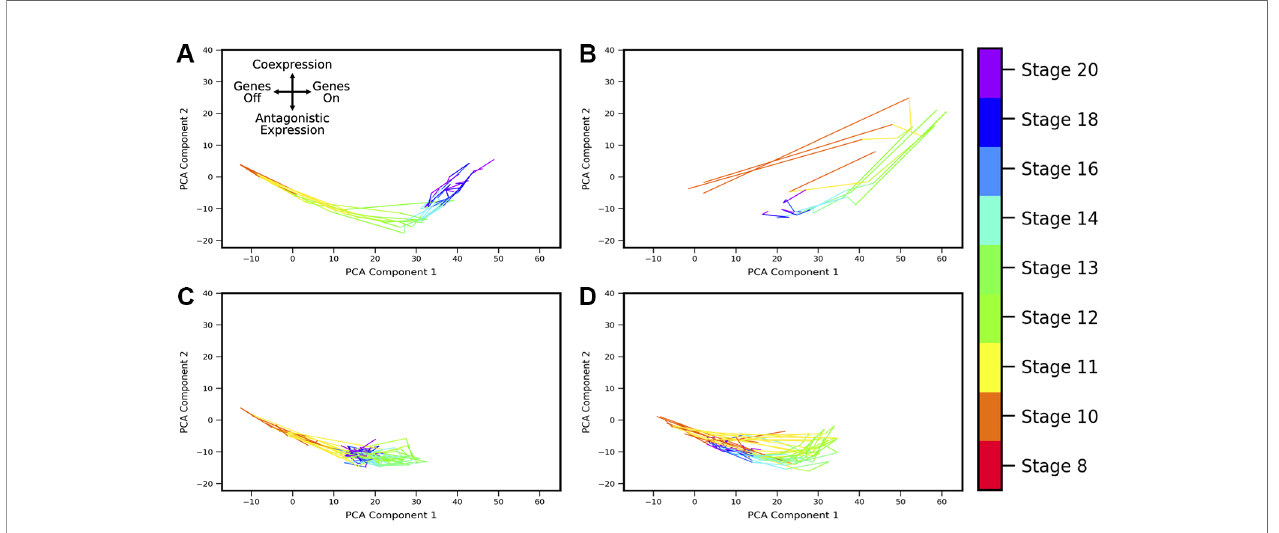
FIGURE 8 | Landscape shape trajectory clustering reveals conserved patterns of gene-pair coexpression dynamics during development. Four representative trajectory clusters showing distinct dynamics are presented (full list of 24 clusters and associated gene pairs in Supplement ). Gene pairs in cluster (A) display behavior of an “ inverted MLP ” : fi rst undergoing increasing antagonistic expression which then switches to increasing coexpression around stage 13. Gene pairs in cluster (B) follow the typical MLP behavior, with highest coexpression taking place around stage 10 followed by antagonistic expression at later stages. Cluster (C) shows consistent antagonistic expression (negative component 2), with nonmonotonic overall expression (a switch-back in component 1 around stage 12). (D) shows cyclic behavior similar to (B) , with highest coexpression at stage 12, but overall expression and relative amount of coexpression is